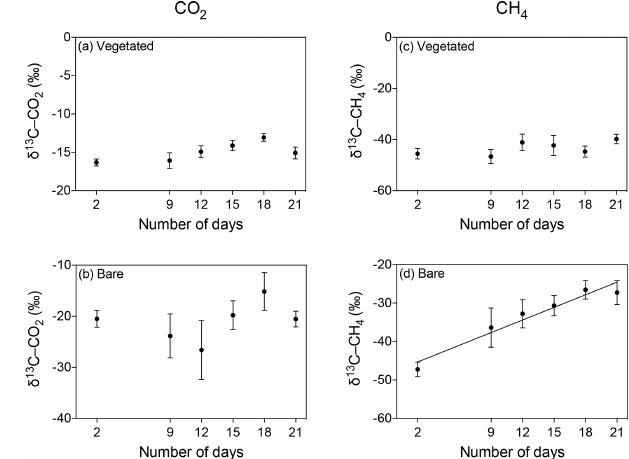
Figure 7. Mean ± SE isotopic signature of CO 2 ( δ 13 C-CO 2 , left) and CH 4 ( δ 13 C-CH 4 , right) in (a, c) vegetated and (b, d) bare sedi- ments exposed to prolonged darkness over the experimental period (number of days since the onset of the